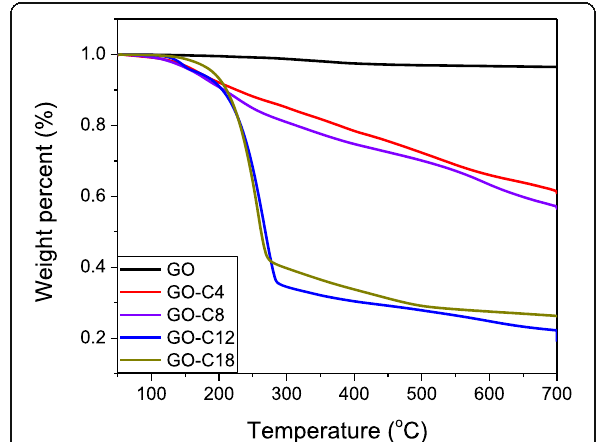
Fig. 3 The TGA analysis of SA-GO which is prepared by the reactions of butylamine (GO-C4), octylamine (GO-C8), laurylamine (GO-C12), octadecylamine (GO-C18), and the sulfur-doped graphene oxide (the oxidation time of the graphene oxide is 24 h)